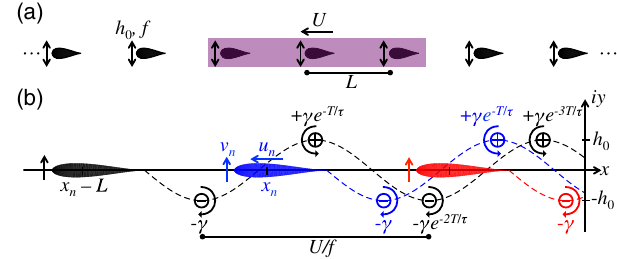
FIG. 1. In-line formation of flapping swimmers. (a) The swimmers oscillate periodically with flapping frequency f and amplitude h 0 . The distance L between swimmers is fixed, and the formation ’ s speed U is determined by the balance of drag and thrust on the swimmers. The swimmers interact with their nearest neighbors, as indicated by the shaded box. (b) Diagram of the theoretical model in Eq. (1), presented in the complex plane z ¼ x þ iy . The formation ’ s dynamics is determined by the swimmer at the center, and we track its position x , horizontal n − 1 Þ n 2 π fh velocity u , and vertical velocity v 0 at the mid- n n ¼ ð plane y ¼ 0 . Vortices of positive (negative) circulation (cid:3) γ are shed from the swimmers ’ trailing edges at the peaks (troughs) y ¼ (cid:3) h 0 of their trajectories, indicated by the dashed